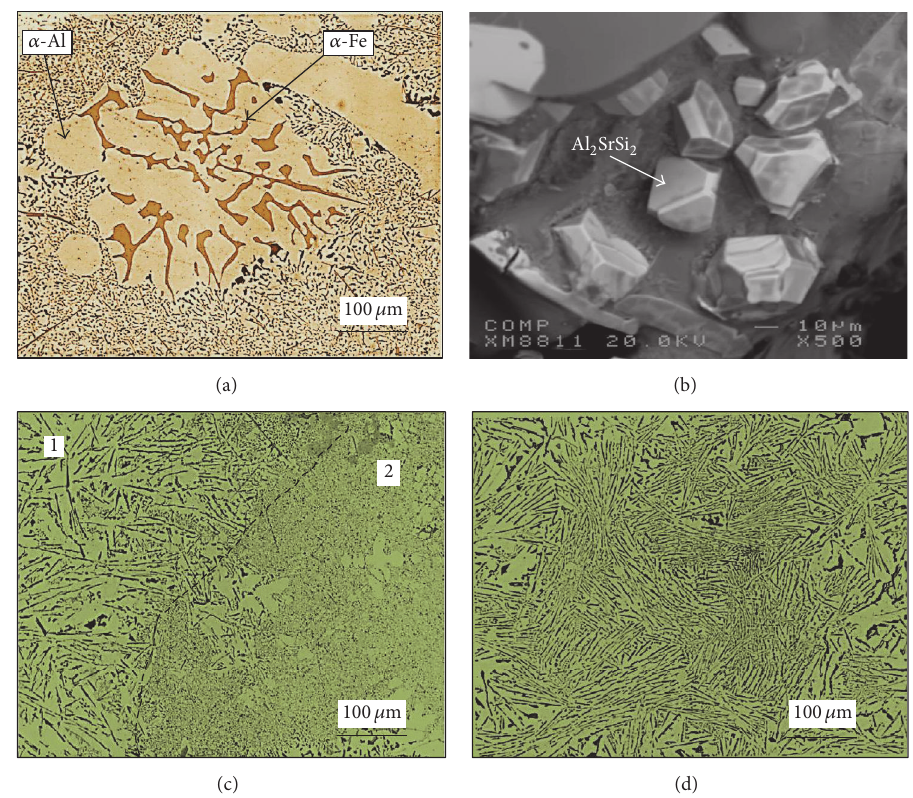
Figure 3: Morphology of the eutectic Si particles in the as cast condition for A413 alloy containing (a) 200 ppm Sr; note the precipitation of 𝛼 -Fe within the 𝛼 -Al dendrite; (b) 340 ppm Sr; (c) 103 ppm Sr + 53 ppm P; and (d) 56 ppm Sr + 56ppm P (see Table 3).